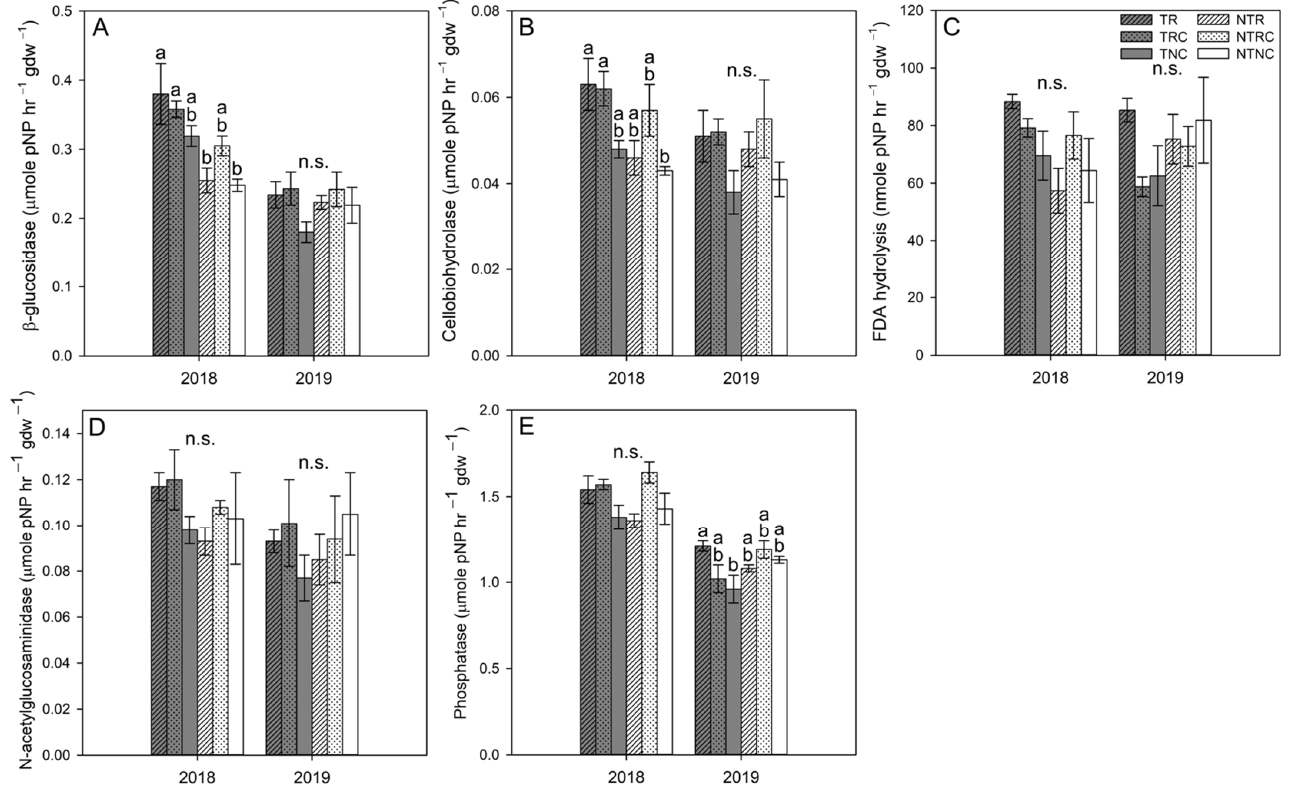
Figure 6. Activities of β -glucosidase ( A ), cellobiohydrolase ( B ), FDA hydrolysis ( C ), N-acetylglucosaminidase ( D ), and phosphatase ( E ) in 5–15 cm soil from till (T) and no-till (NT) plots planted with winter cover crop treatments of rye only (R), rye+clover (RC), and no cover (NC) in spring 2018 and 2019. Values represent the mean ± standard error. Statistical significance between treatments for each timepoint are denoted by different letters ( α = 0.05). Timepoints marked with n.s. indicated no significant differences between pairwise comparisons.